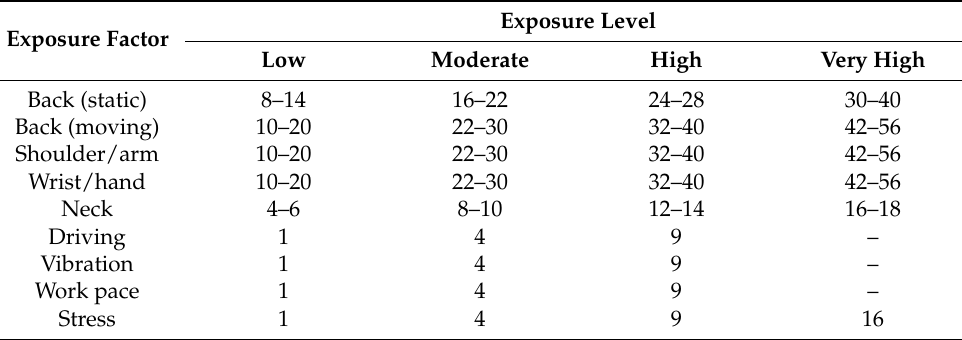
Table 3. Proposed exposure levels for QEC